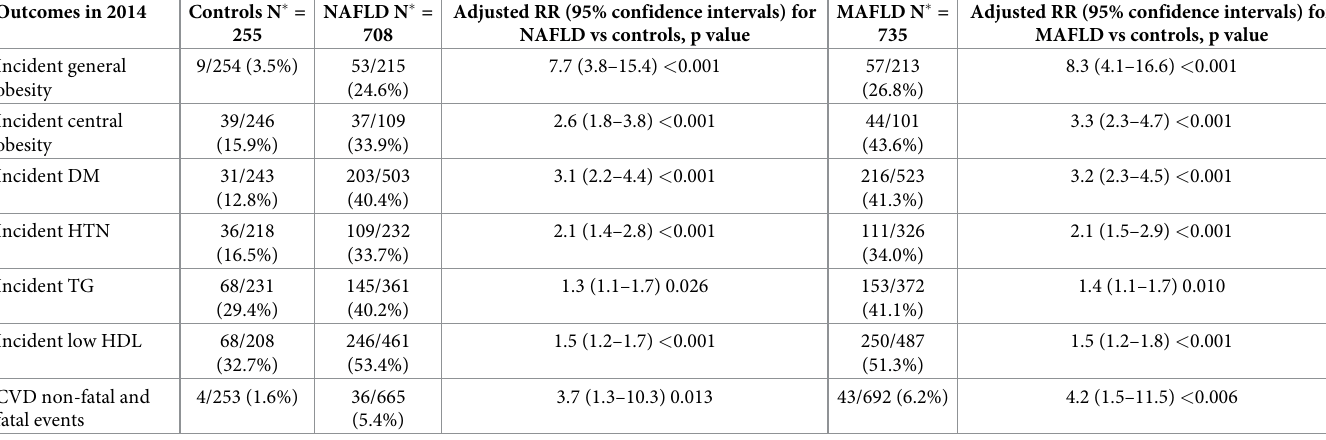
Table 2. New-onset metabolic features and cardiovascular events (with n, % and age-sex adjusted risk ratios) after 7-years (2014), among control, NAFLD and MAFLD.